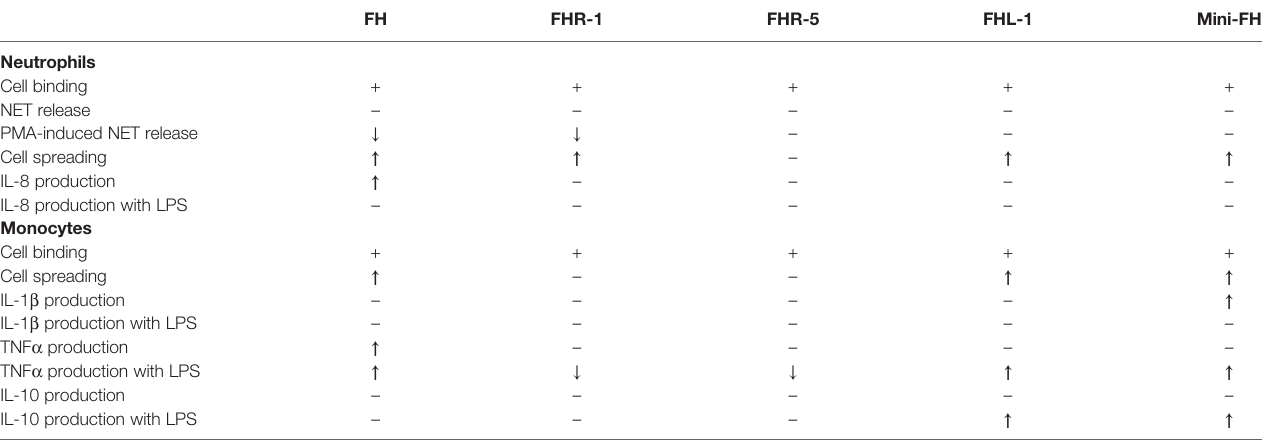
TABLE 1 | Summary of the effects of FH, FHR-1, FHR-5, FHL-1 and mini-FH on different cell functions. FH FHR-1